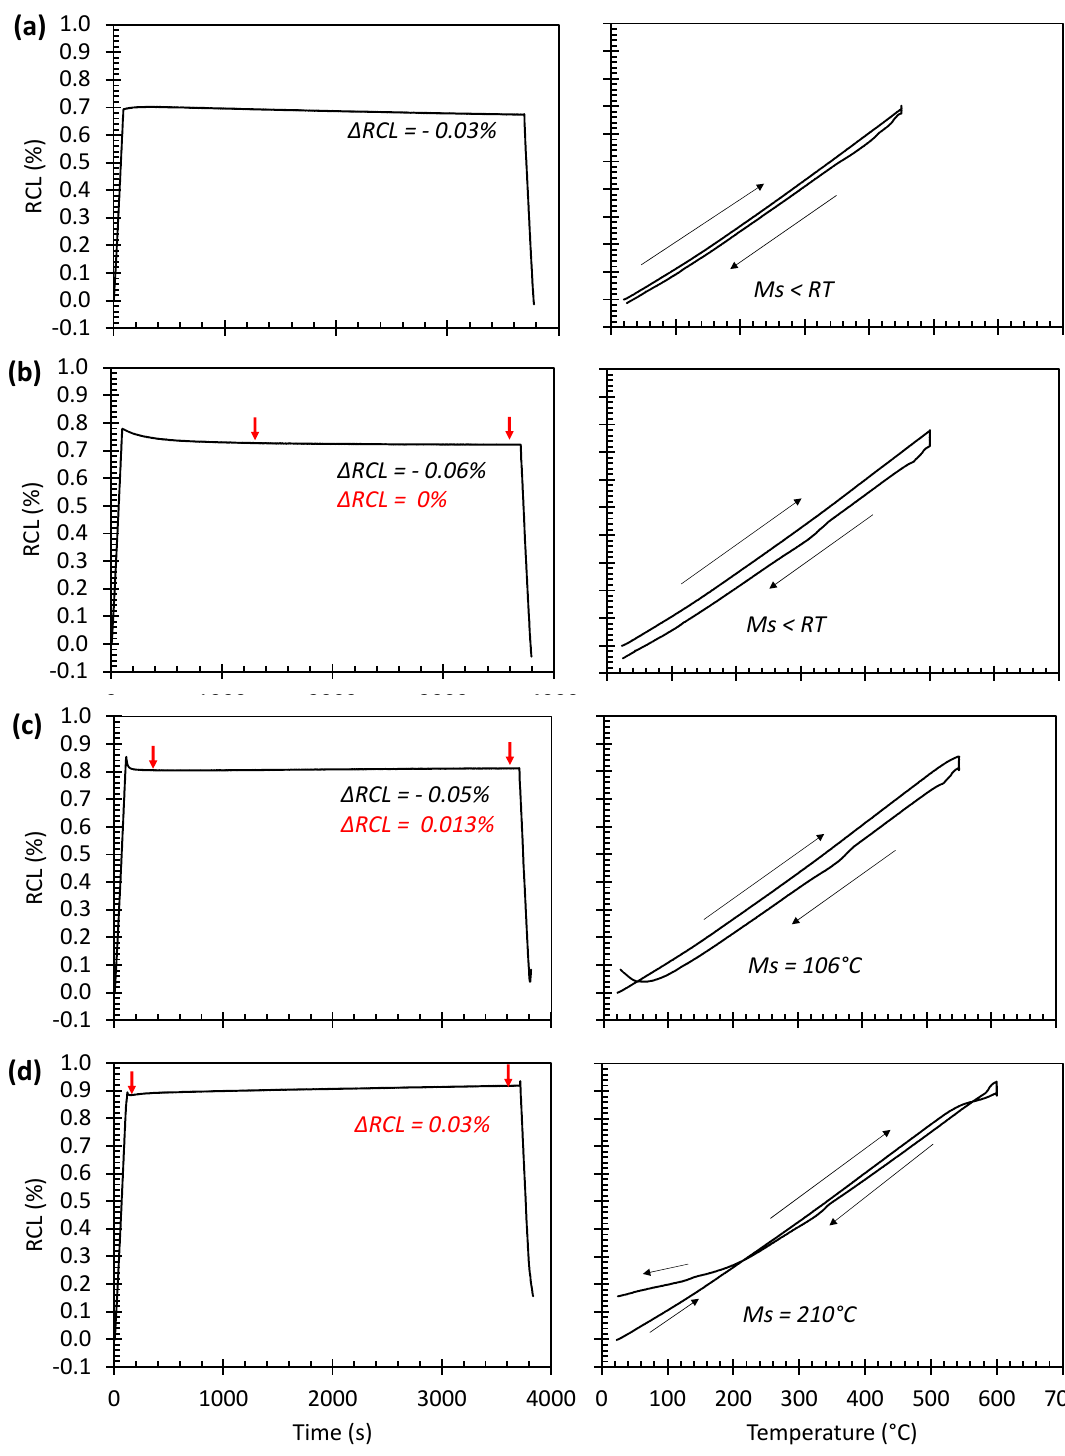
Figure 7. Relative change in length (RCL) as a function of time and temperature for 06C1MoV steel tempered at ( a ) 450 °C, ( b ) 500 °C, ( c ) 550 °C, and ( d ) 600 °C.